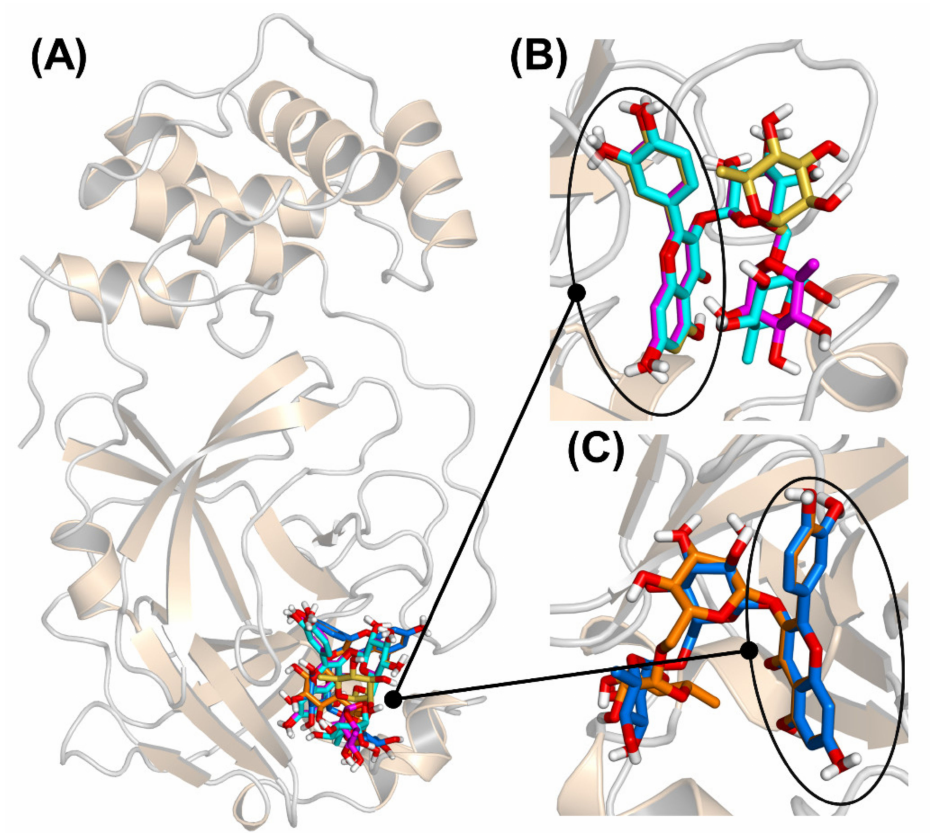
Figure 5. Docking poses of rutin in the active site of the main protease 3CLpro, shown at different rotation angles in the three panels. ( A ) Ribbon representation of the protein, with the most favorable docking poses superimposed; ( B ) Cluster of three docking poses (cyan, magenta, and yellow), with the quercetin moieties (circled) almost coincident, and the rutinose regions pointing outwards; ( C ) Cluster of two docking poses (blue and orange); the quercetin moieties are still almost coincident, and the rutinose regions extend on the other side with respect to the other cluster (panel